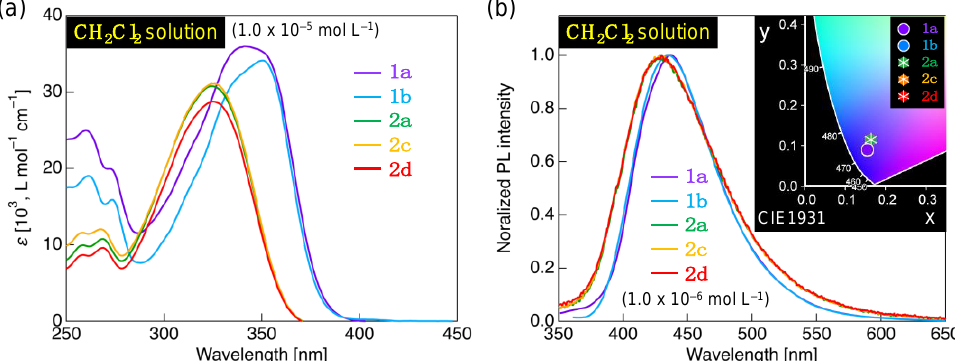
Figure 3. ( a ) UV–vis absorption (concentration: 1.0 × 10 − 5 mol L − 1 ) and ( b ) PL spectra (concentration: Figure 3. ( a ) UV – vis absorption (concentration: 1.0 × 10 −5 mol L −1 ) and ( b ) PL spectra (concentration: 1.0 × 10 − 6 mol L − 1 ) of semifluoroalkoxy-containing D- π -A-type fluorinated tolanes 1 and 2 . Inset: 1.0 × 10 −6 mol L −1 ) of semifluoroalkoxy-containing D-  -A-type fluorinated tolanes 1 and 2 . Inset: Commission Internationale de l’Eclailage plot of their PL colors. Commission Internationale de l’Eclailage plot of their PL colors. Table 1. Photophysical data of semifluoroalkoxy-containing D- π -A-type fluorinated tolanes 1 and 2 Table 1. Photophysical data of semifluoroalkoxy-containing D-  -A-type fluorinated tolanes 1 and 2 in CH 2 Cl 2 solutions and crystalline states. in CH 2 Cl 2 solutions and crystalline states.